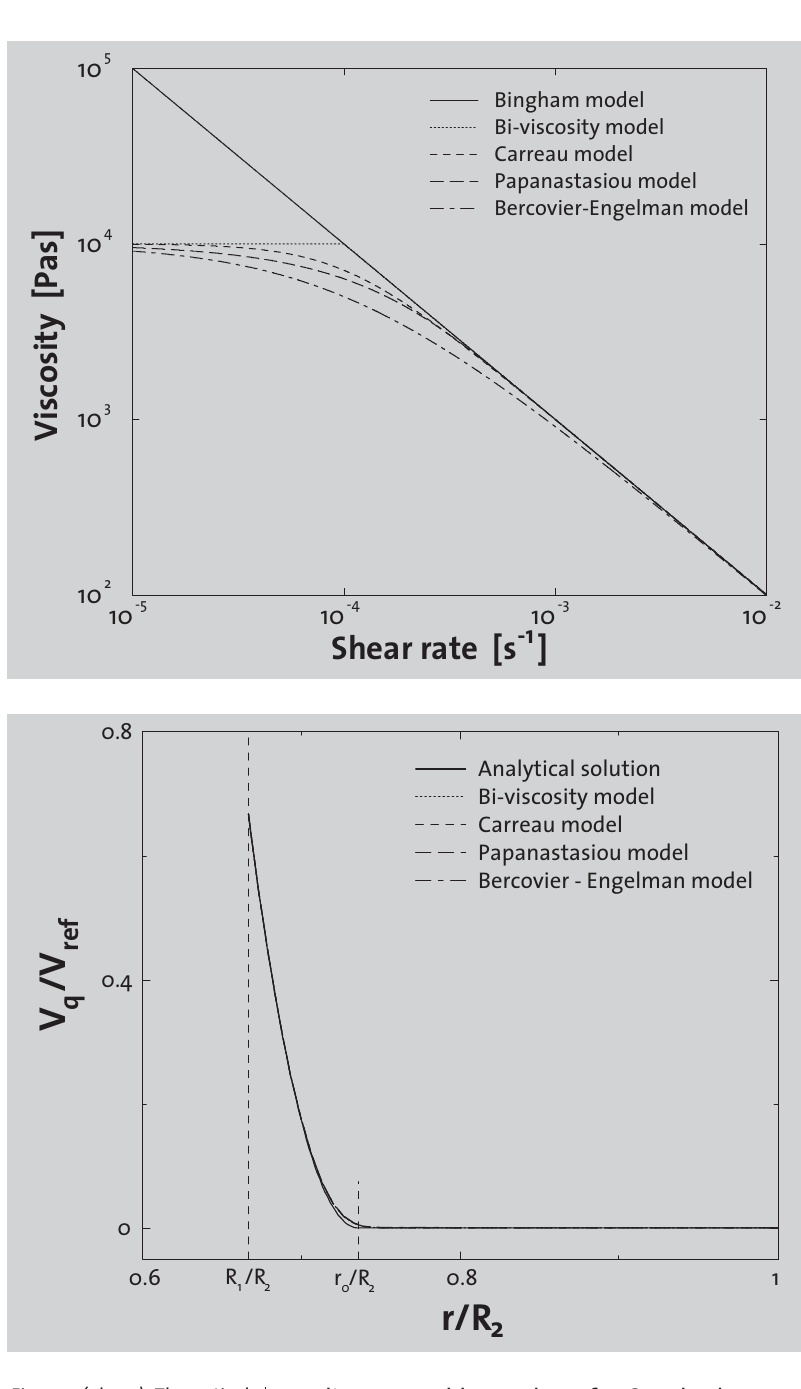
Figure 2 (above): Theoretical viscosity for approached Bingham models. Figure 3 (below): Tangential velocity profiles in Couette